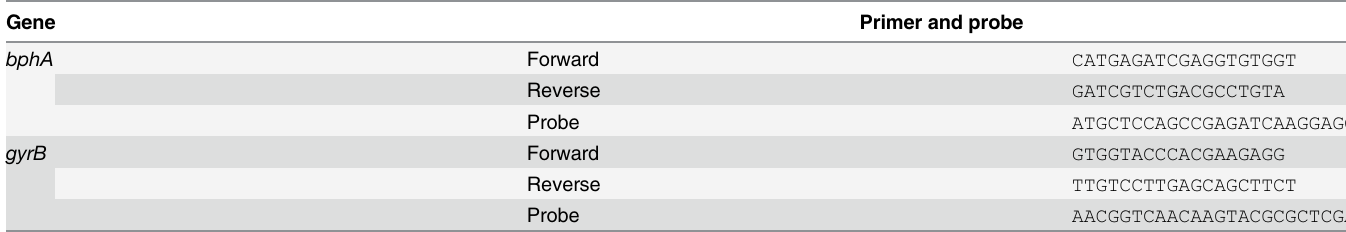
Table 2. Primers and probes used for